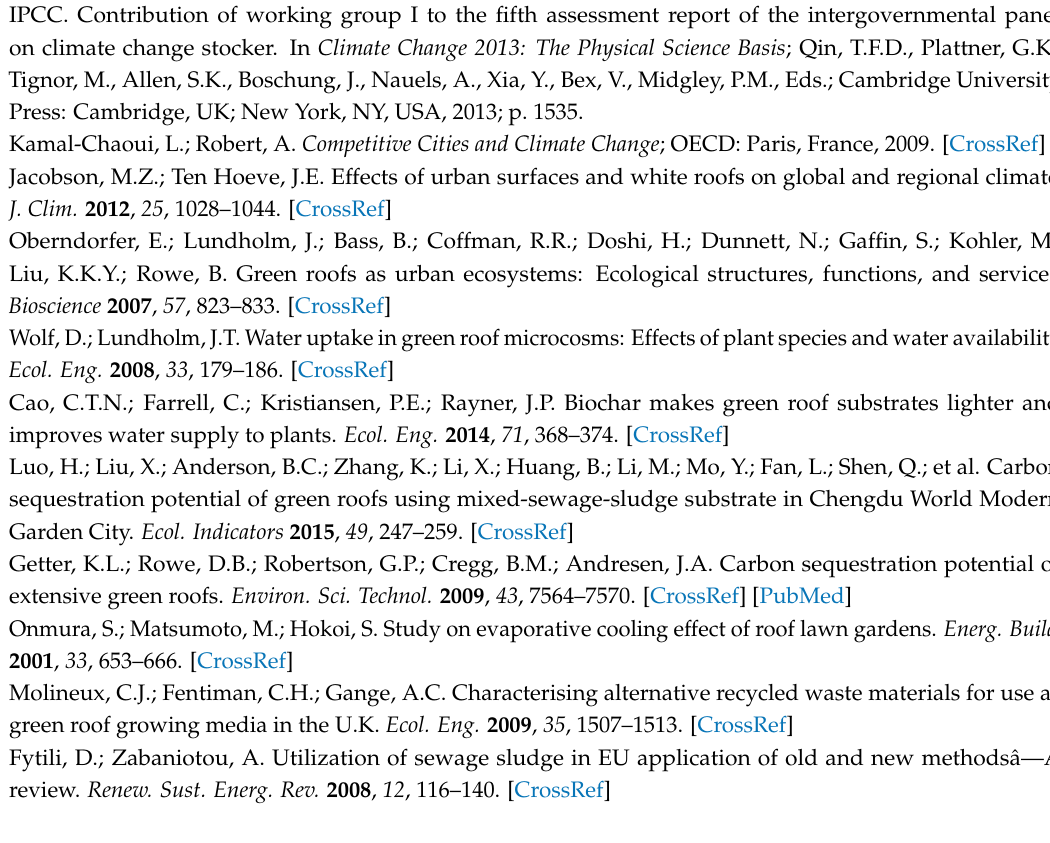
Table S1: Properties of initial substrates urban-natural-soil (CK), sewage sludge (SS) and sludge biochar (SB) of green roof before planting. Table S2: The physical and chemical properties of soil on the green